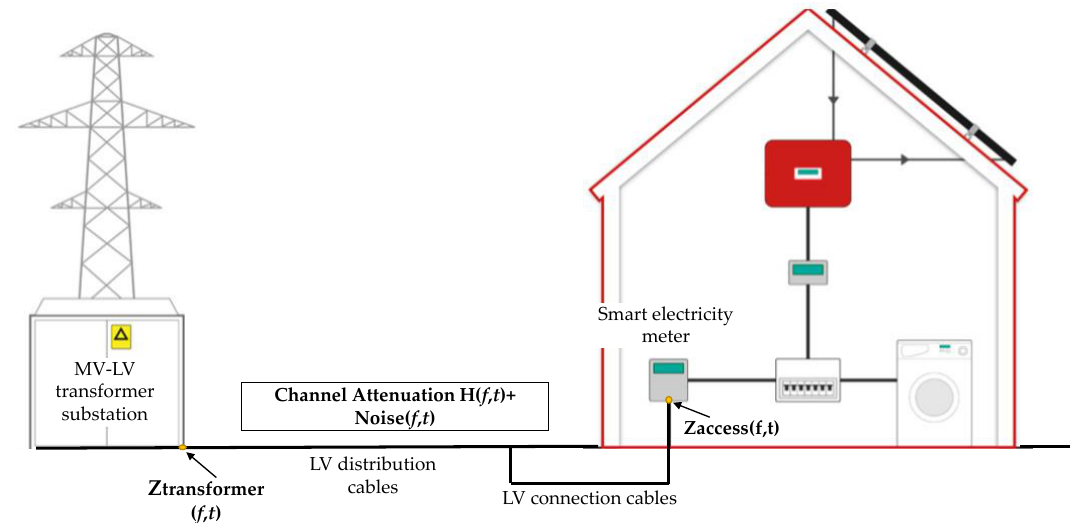
Figure 2. Example of narrowband powerline communication (NB-PLC) channel representation in the low voltage (LV) network.